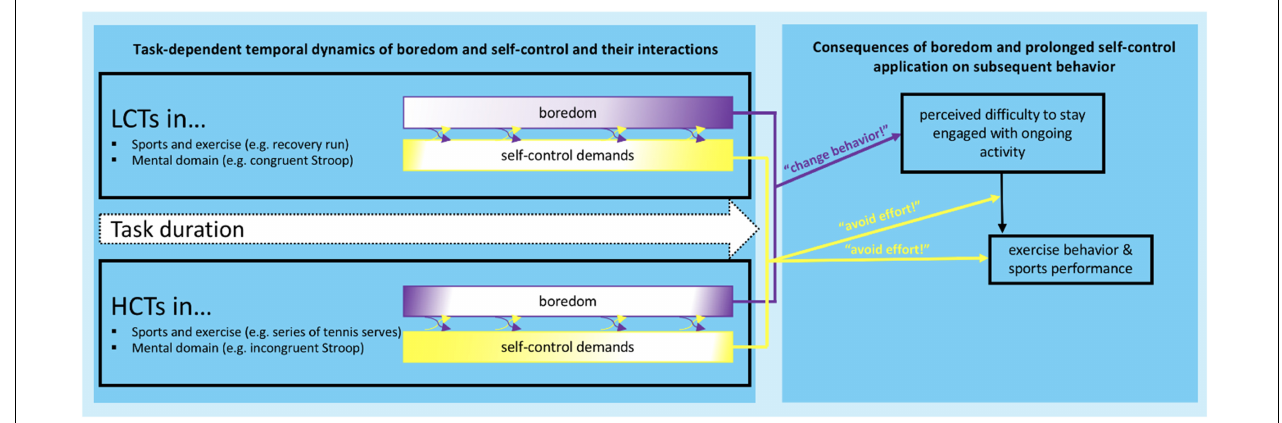
FIGURE 1 | Working model on the proposed interplay of boredom and self-control in modulating exercise behavior and sports performance (model adapted from Martarelli and Wolff, 2020; Wolff and Martarelli, 2020). The left panel visualizes the temporal dynamics of task-induced boredom and self-control demands as a function of the type of task [low control task (LCT); vs. high control task (HCT)] and the duration of the task. More specifically, the model proposes that task characteristics change as a function of task duration which in turn leads to changes in task-imposed self-control demands and task-induced boredom. The color gradients reflect the potential changes in respective signal strength as a function of time on task. For example, an LCT (e.g., recovery run) that becomes monotonous and under-stimulating over time, might become more boring over time, and to keep going despite being bored increases the run’s self-control demands. On the other hand, HCTs can lead to the experience of boredom at the beginning due to over-stimulation (e.g., tennis serves executed by a novice) and at the end due to under-stimulation (e.g., as a result of overlearning). The left panel is a schematic representation of the assumed temporal dynamics and the arrows that connect boredom and self-control demands indicate that both signals are expected to affect each other. Importantly, the temporal dynamics of each sensation must not be linear and are assumed to depend on task characteristics and individual differences (for a comprehensive version of the model and an in-depth discussion, please see Wolff and Martarelli, 2020). The right panel visualizes the behavioral relevance of boredom and self-control exertion in affecting sports performance and exercise behavior. Boredom signals whether one should explore more rewarding alternative activities (“change behavior!”) and self-control demands signal whether one should avoid investing further effort (“avoid effort!”). Thus, at any given time during the task (visualized by the arrow on the left panel), those signals are expected to vary in strength. The model proposes that boredom has a direct effect on the perceived difficulty to stay engaged with an ongoing activity, which in turn impacts ongoing exercise behavior and sports performance. Successful participation and performance in sports relies on self-control; therefore, the model proposes that self-control moderates the effect of perceived difficulty on exercise behavior and sports performance. Crucially, other variables are likely to influence the proposed relationships, such as differences in perceived meaning and trait boredom or trait self-control might moderate the velocity of gradient changes over